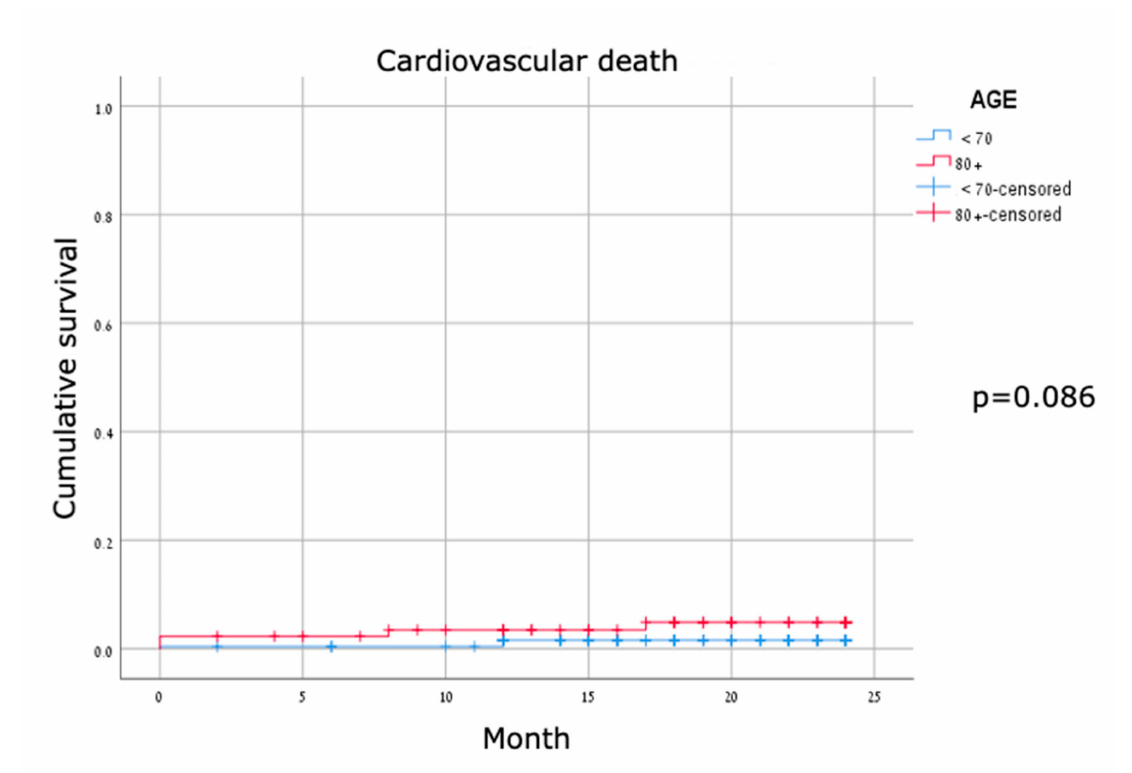
Figure 3. Kaplan–Meier curves for cardiovascular death.